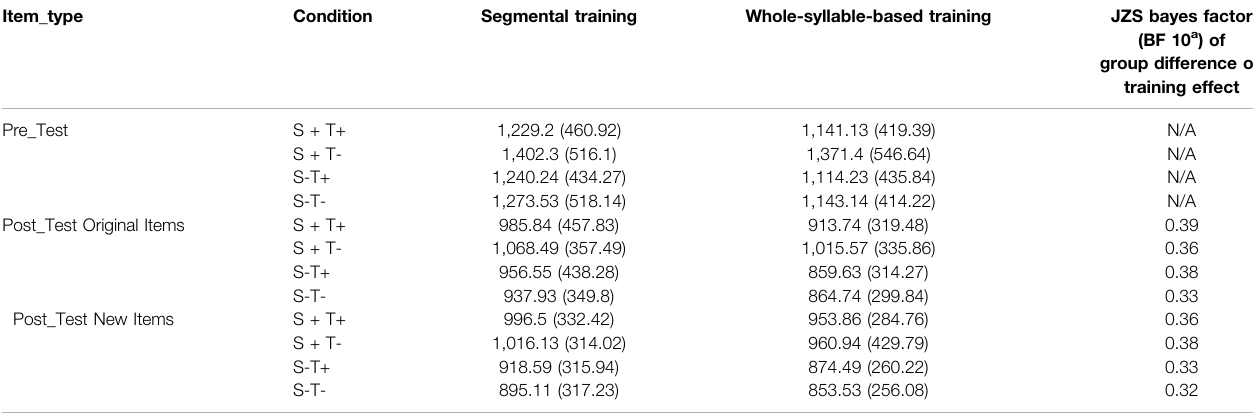
TABLE 3 | RTs (SDs in parentheses) on All Conditions and Item Types in the Same-Different Phonological Judgment Task in Both Segmental and Whole-Syllable-Based Training Groups.